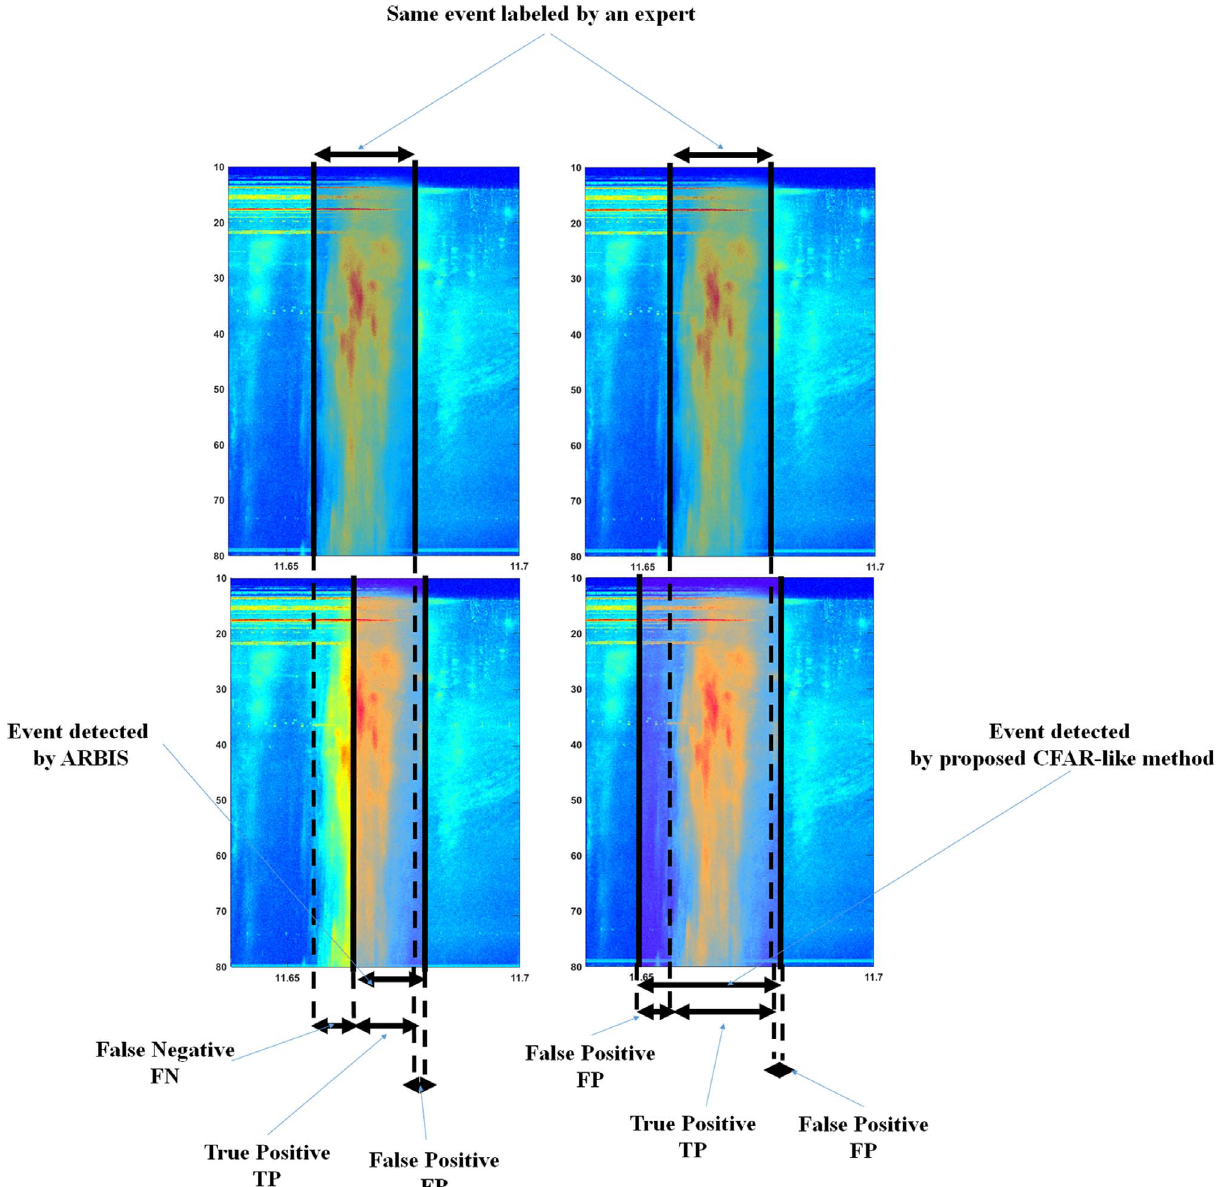
Fig. 19. Protocol used to evaluate the duration of the events detected by the method proposed in the present work and the ARBIS system in comparison with the duration of the event (start and end of the event) labeled by an